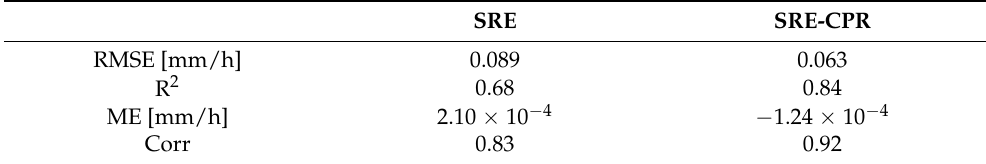
Table 6. Error statistics of the SRE module.